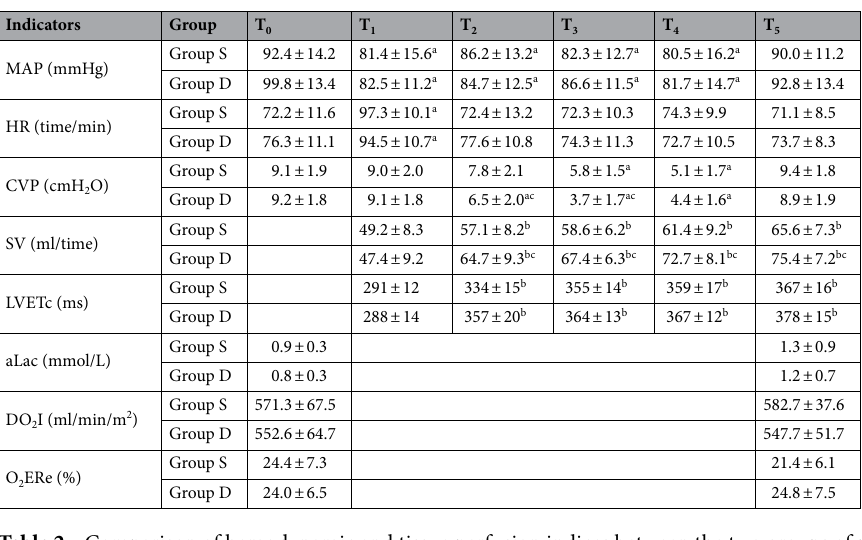
Table 2. Comparison of hemodynamic and tissue perfusion indices between the two groups of patients ( x ± s). Compared with T 0 , a P < 0.05; compared with T 1 , b P < 0.05; compared with group S, c P < 0.05.